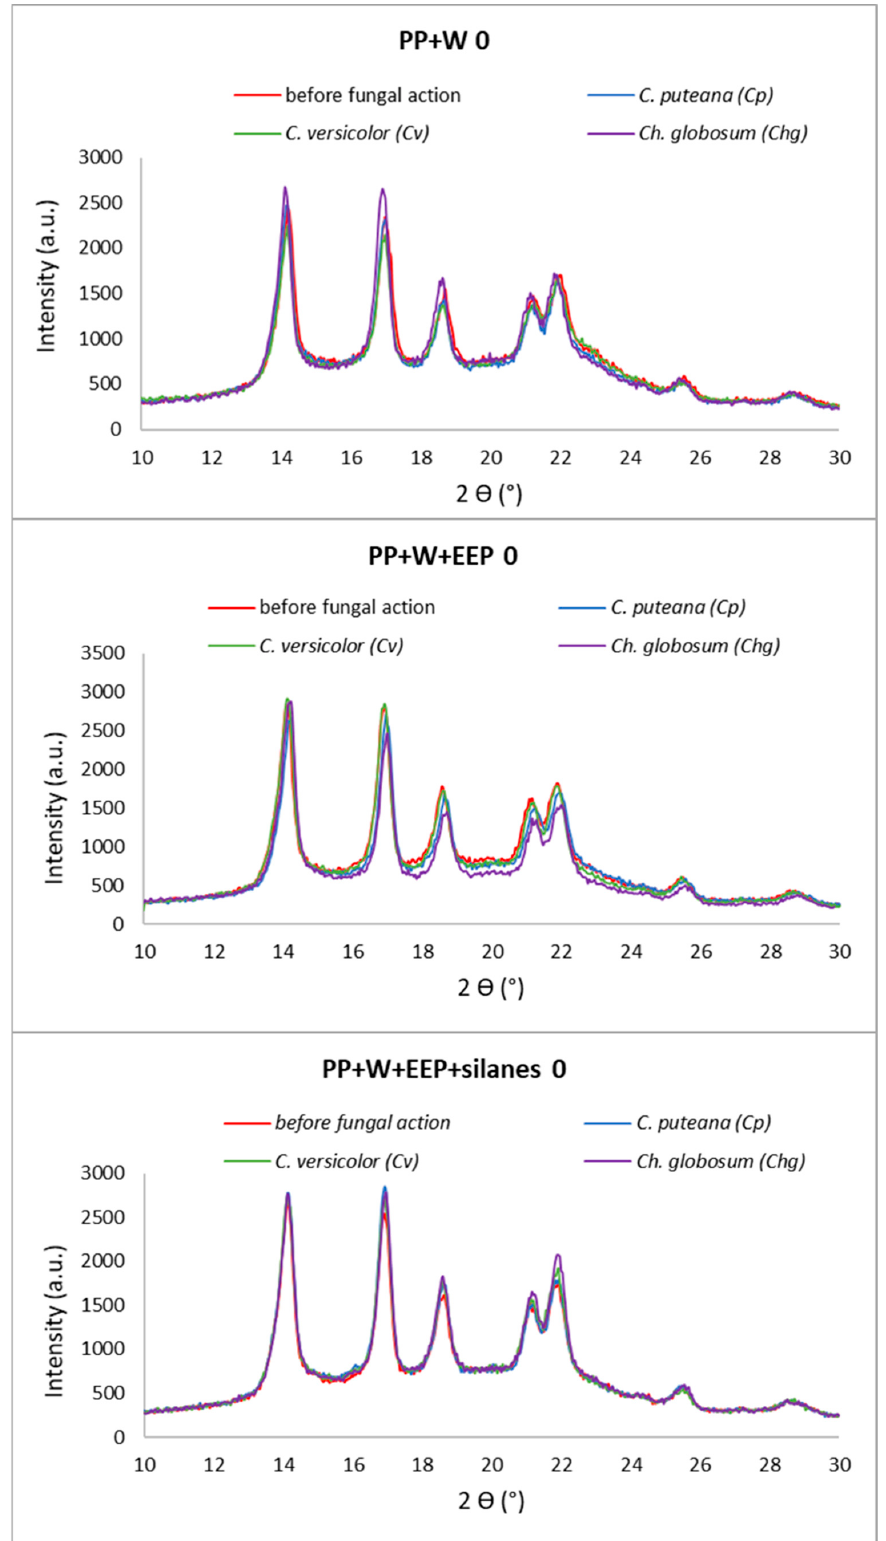
Figure 7. X-ray diffraction pattern of composites without UV aging.